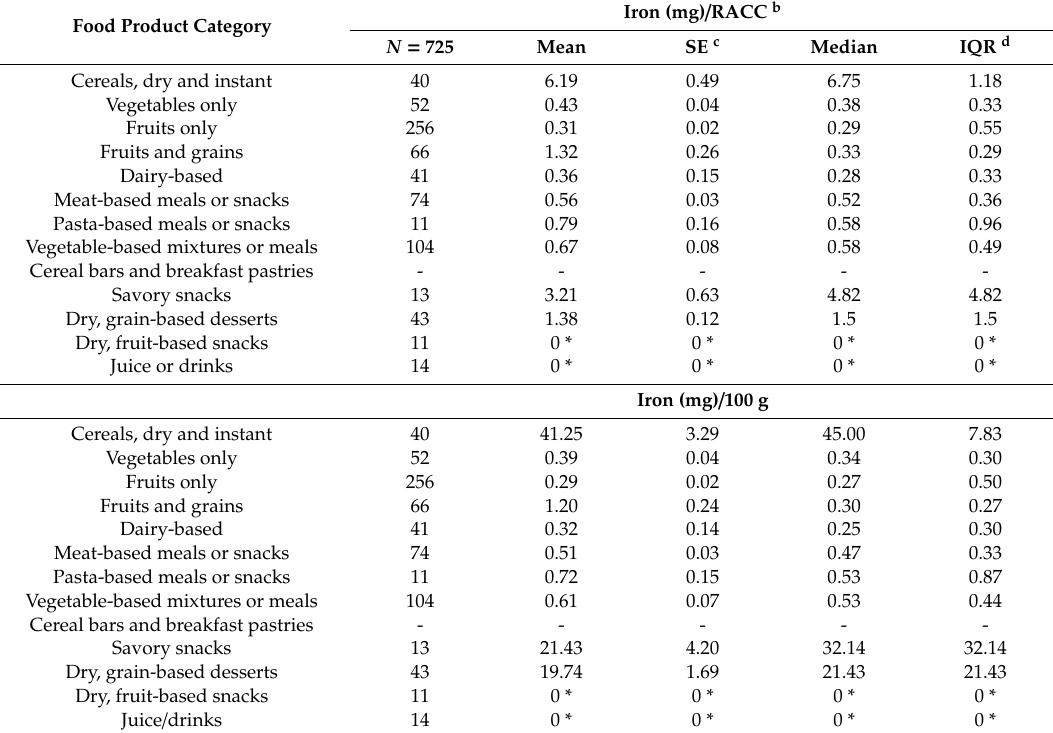
Table 2. Iron content per reference amount customarily consumed (RACC) and per 100 g of infant a food and drink products by food product category,